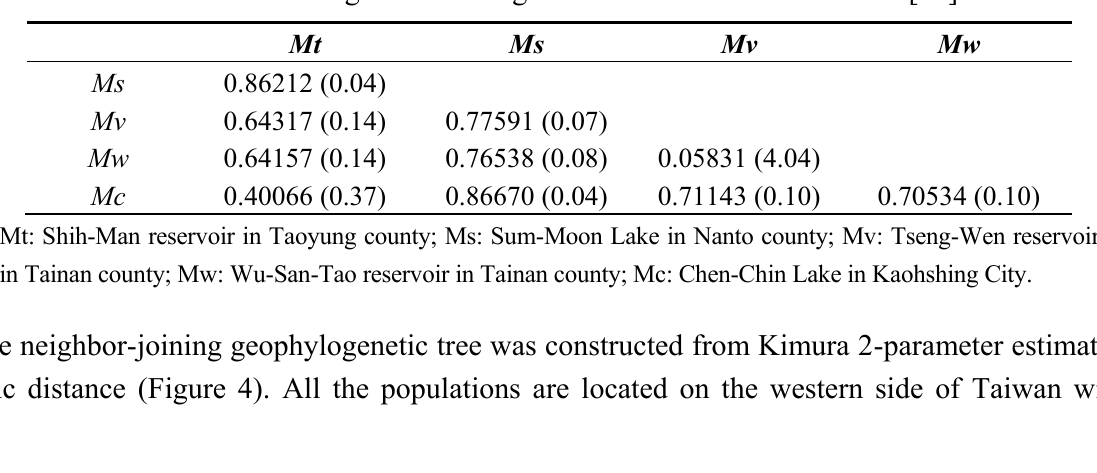
) and gene flow parameter (N , in m st